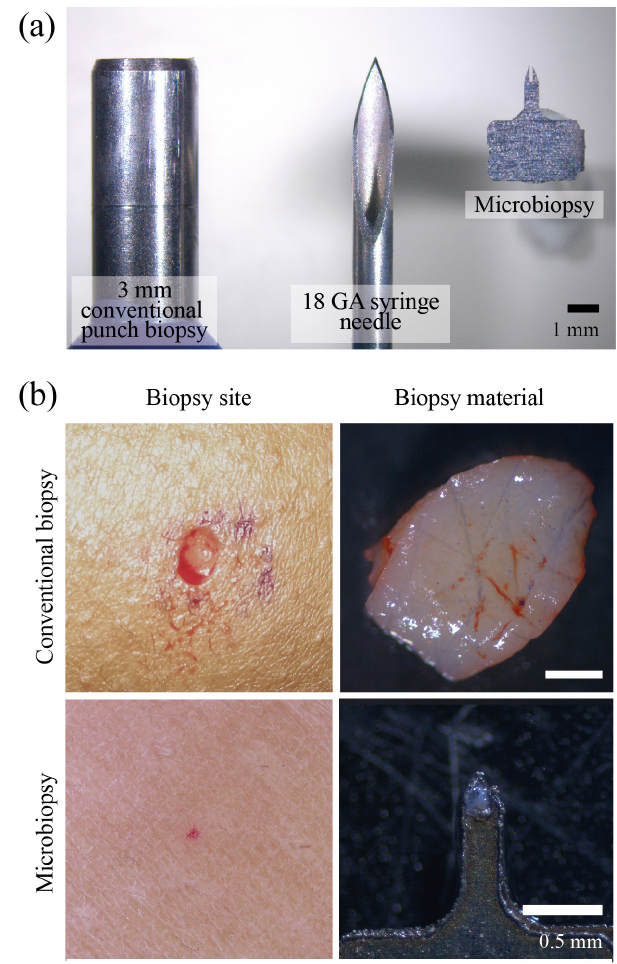
Figure 1. Size comparison of needle, biopsy devices and biopsy comparisons. A conventional biopsy punch is shown on the left, an 18 gauge syringe needle in the centre and the inner chamber of our microbiopsy device on the right Panel ( a ) our microbiopsy device chamber is 0.15 mm in width with an outer width of 0.25 mm. The top row of Panel ( b ) contains a conventional 3 mm biopsy site and tissue, whereas the bottom panels show microbiopsied skin and